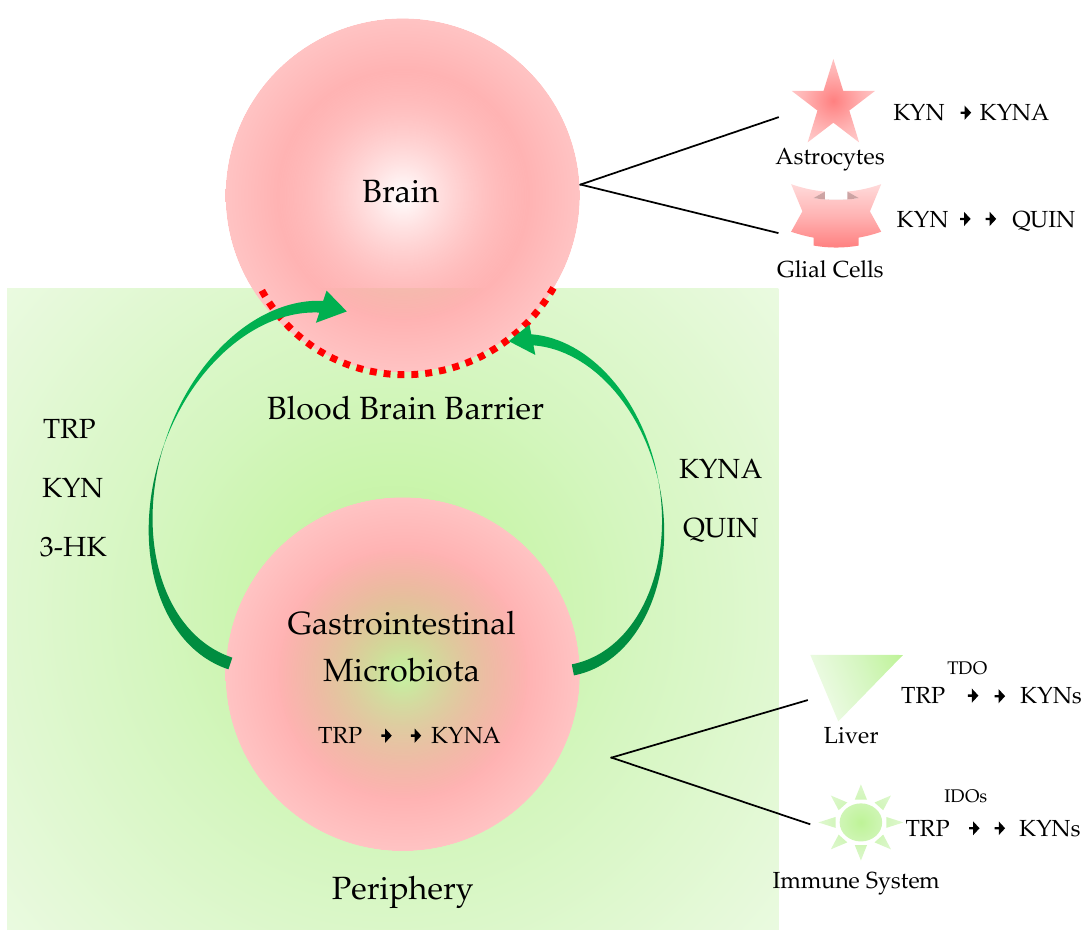
Figure 2. The central nervous system and periphery sequestrated by the blood-brain-barrier and the microbiota-gut-brain axis. The impermeable peripheral metabolites are sequestrated from the central nervous system (CNS) by the blood-brain barrier (BBB). The gastrointestinal microbiota changes the composites of the peripheral metabolites. Tryptophan (TRP), kynurenine (KYN), 3-hydroxykynurenine (3-HK) are permeable, but kynurenic acid (KYNA) and quinolinic acid (QUIN) are impermeable to the BBB. When the integrity of the BBB is compromised such as in inflammation, the microbiota influences the brain function and thus behavior through the microbiota-gut-brain axis. TDO: tryptophan 2,3-dioxygenas; IDO: indoleamine 2,3-dioxygenase.